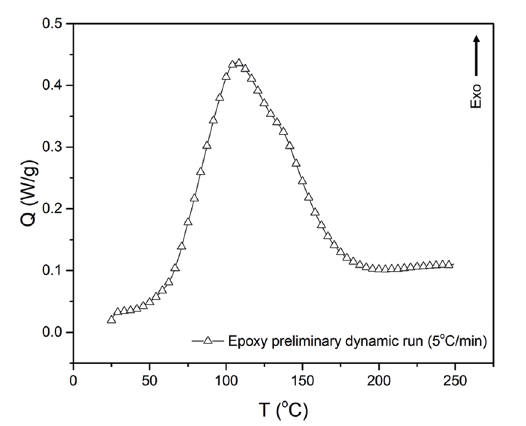
Figure 4. Preliminary dynamic DSC run for the for 1.45mg sample of Araldite ® LY5052/Aradur5052 TM epoxy Table 1. The total enthalpy ( H ) and the kinetic parameters T ( E , lnA , n ) were calculated by the integration of the reaction a